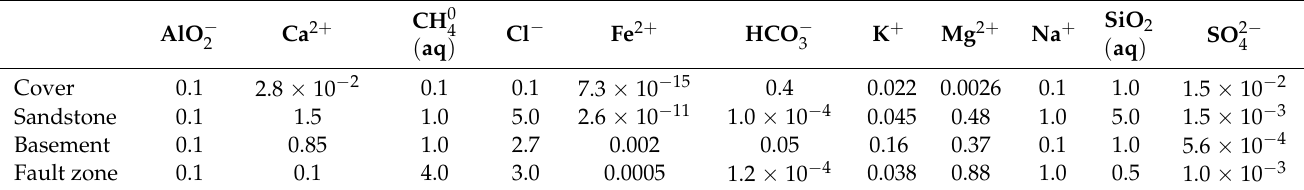
Table 6. Initial aqueous component concentrations (mol/L) of different rock